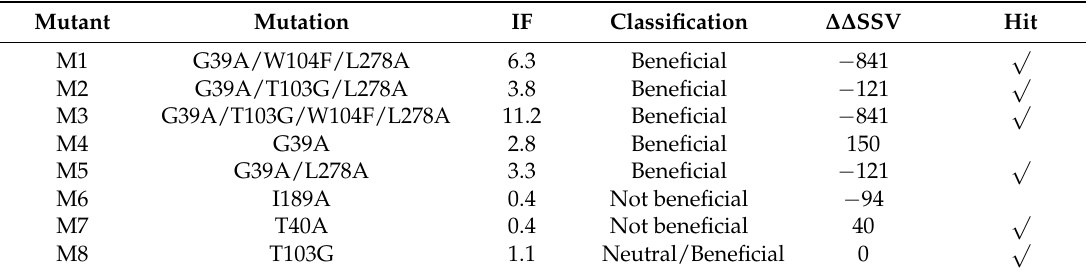
Table 5. CaLB’s mutants evaluated by SSV for comparison to BioGPS. These values were obtained from references